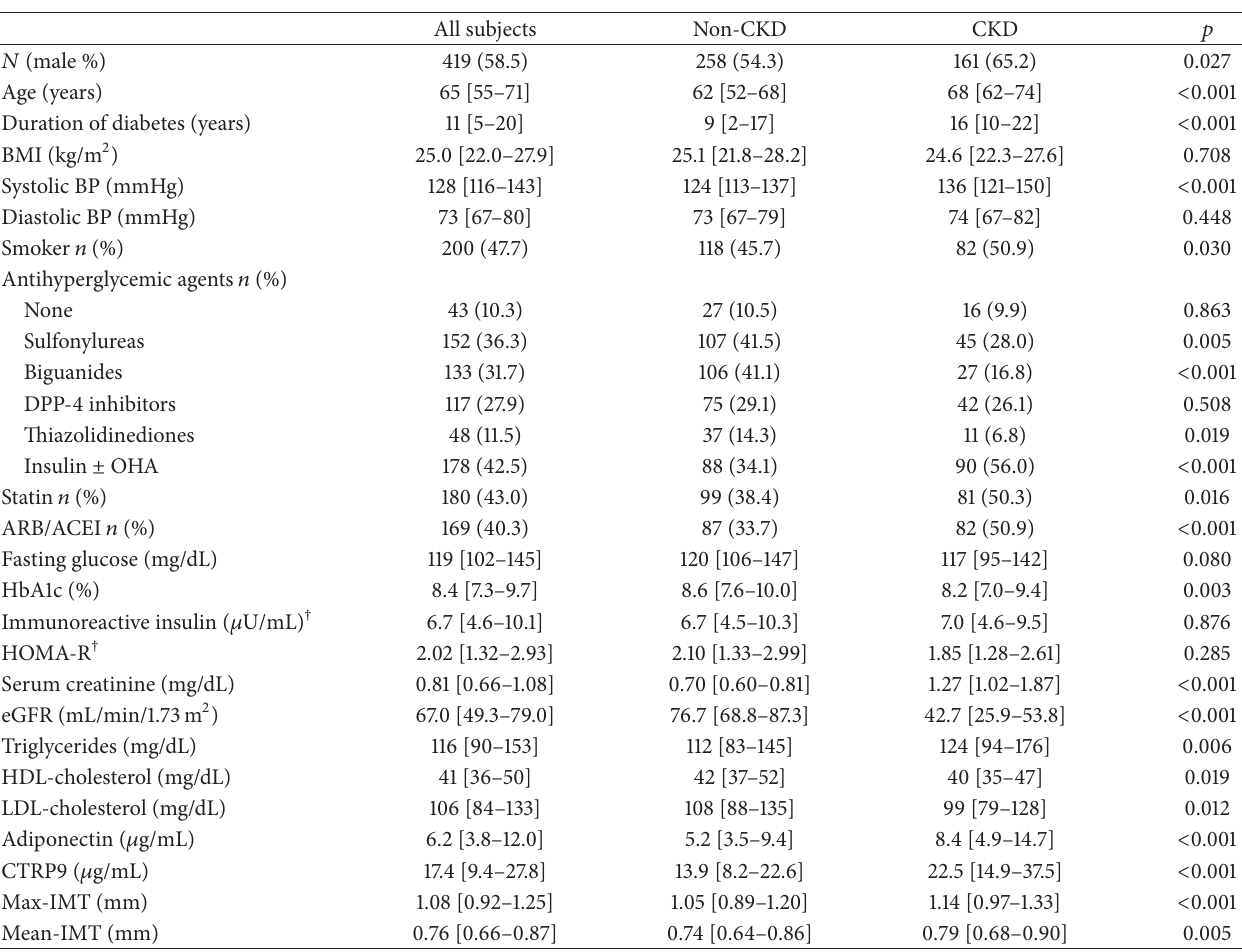
Table 1: Clinical characteristics, plasma CTRP9 levels, plasma adiponectin levels, and carotid IMT in all subjects with type 2 diabetes as well as in subgroups with and without